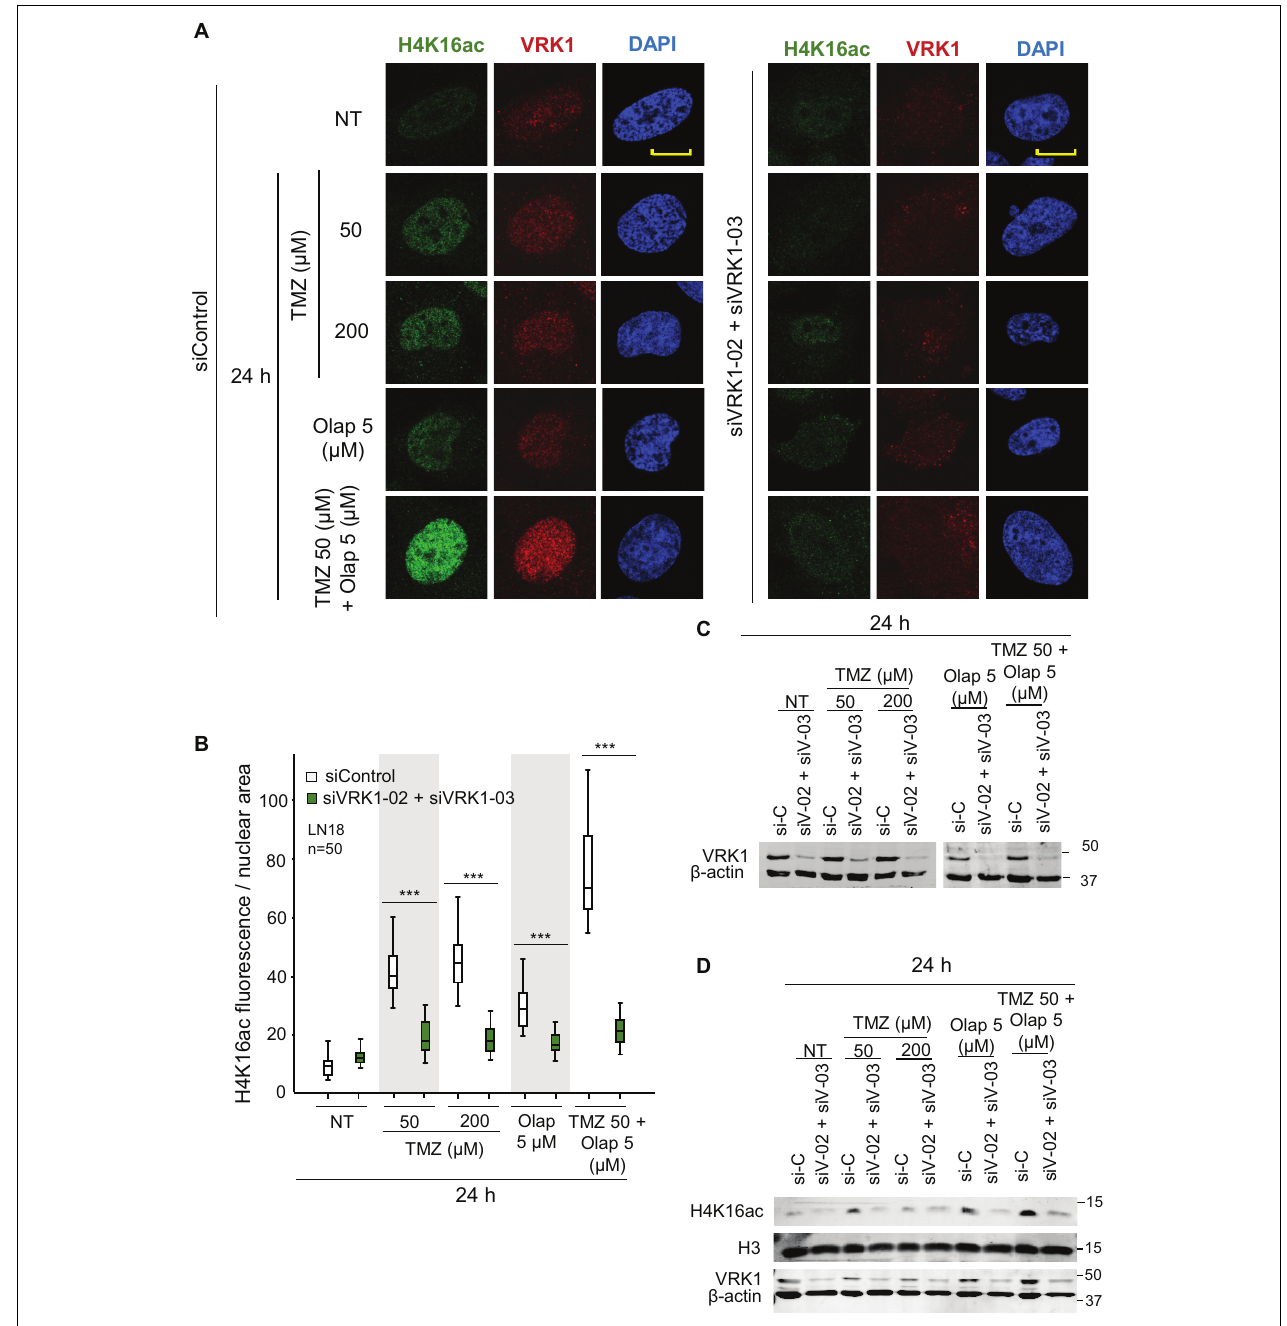
FIGURE 2 | Effect of VRK1 depletion on H4K16 acetylation (H4K16ac) induced by TMZ and olaparib in LN-18 cells. (A) Left. Effect of siControl on H4K16ac induced by TMZ, olaparib and their combination. Right. Effect of the combination of siVRK1-02 and siVRK1-03 on H4K16ac induced by TMZ, olaparib and their combination. (B) Quantification of the effect of VRK1 depletion on H4K16ac per cellular area. Fifty cells in triplicate experiments were quantified. Field images are shown in Supplementary Figure 3 . Scale bar = 10 µ m. *** p < 0.001. (C) Western blot showing the effect of VRK1 knockdown. β -actin was used as load control. NT: no treatment. (D) Effect of the combination of TMZ and olaparib and VRK1 knock-down on H4K16ac detected in